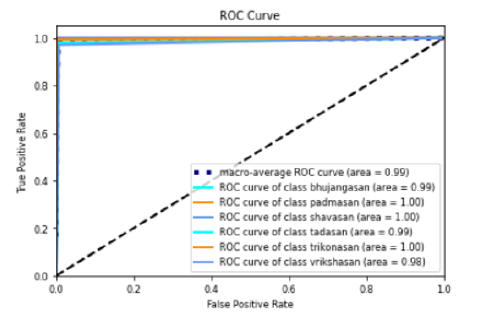
Figure 7. ROC Curve.